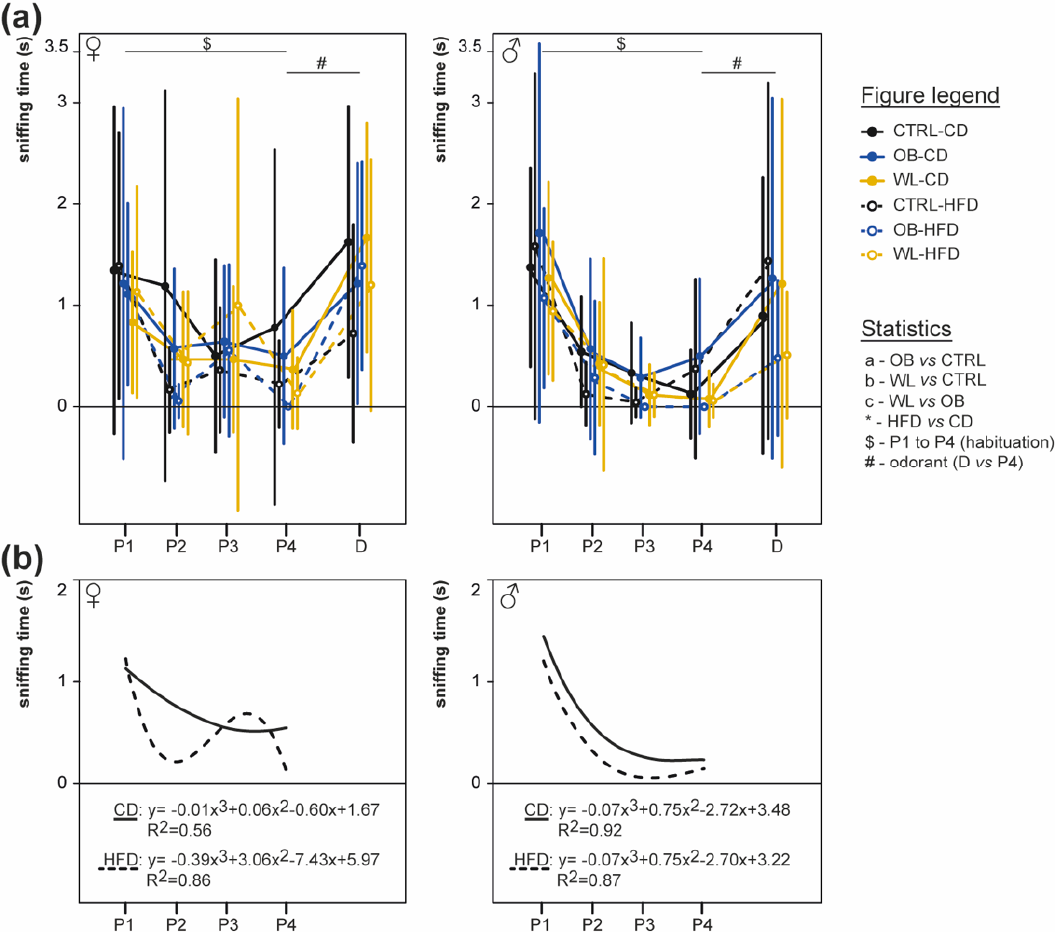
Figure 5. Olfactory discrimination is influenced by maternal and post-weaning diets. The habituation/discrimination test measured the ability to discriminate between a sequentially presented set of odours (four successive presentations of pentanol (P1–P4), followed by decanal (D)) at 5.5 months, after 18 weeks of CD or HFD diet. The exploration time for mice in response to the odorant presentation is given as mean ± SD ( a ) for female (left; CTRL-CD n = 17, CTRL-HFD n = 18, OB-CD n = 7, OB-HFD n = 9, WL-CD n = 15, WL-HFD n = 15) and male (right; CTRL-CD n = 11, CTRL-HFD n = 12, OB-CD n = 7, OB-HFD n = 7, WL-CD n = 12, WL-HFD n = 17). Regression curves for CD-fed and HFD-fed mice during habituation (P1–P4; ( b )) for females (left) and male (right).